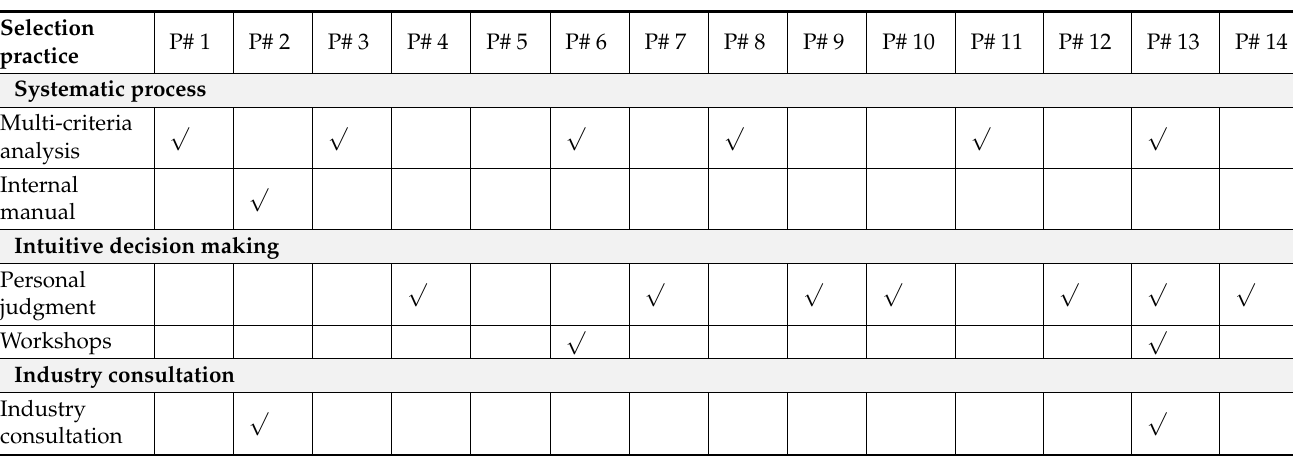
Table 3. ECI selection